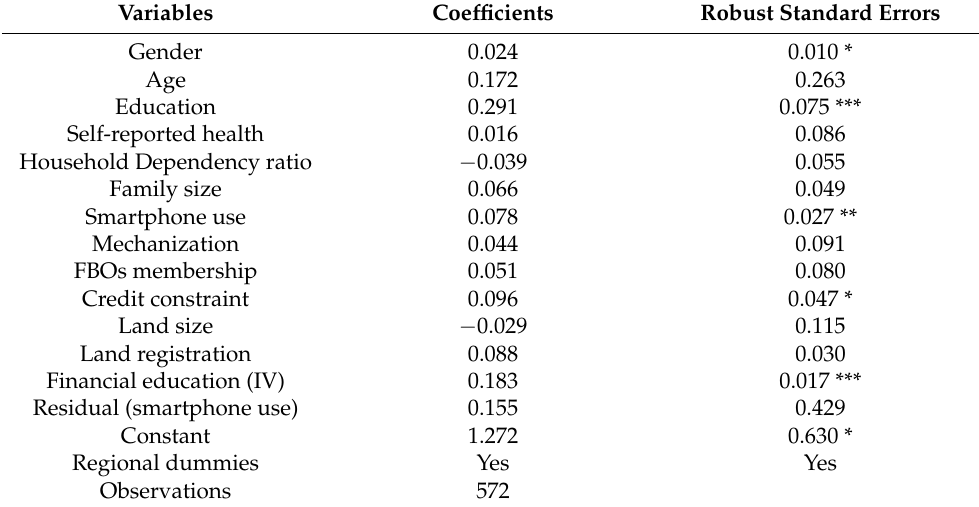
Table 3. Financial literacy